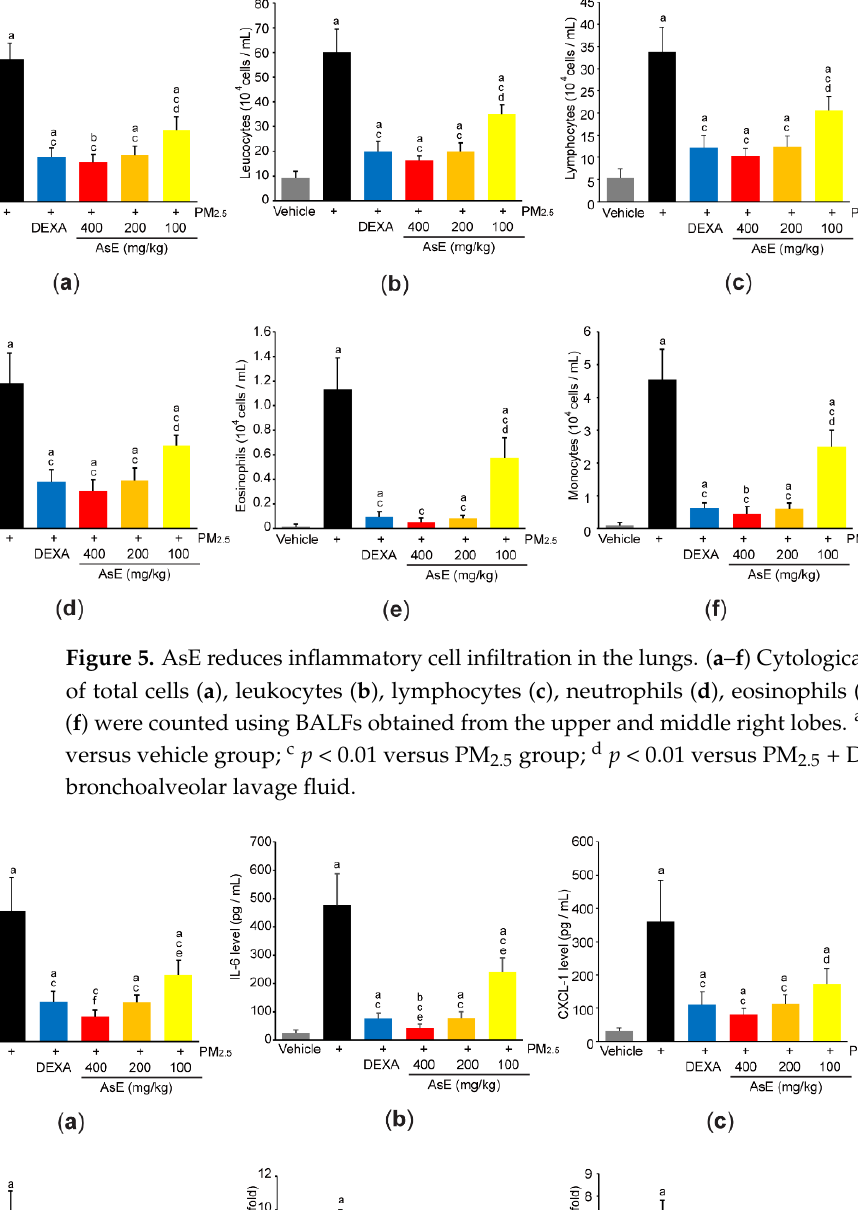
Figure 5. AsE reduces inflammatory cell infiltration in the lungs. ( a – f ) Cytological analysis. Number of total cells ( a ), leukocytes ( b ), lymphocytes ( c ), neutrophils ( d ), eosinophils ( e ), and monocytes ( f ) were counted using BALFs obtained from the upper and middle right lobes. a p < 0.01, b p < 0.05 versus vehicle group; c p < 0.01 versus PM 2.5 group; d p < 0.01 versus PM 2.5 + DEXA group; BALF, bronchoalveolar lavage fluid.